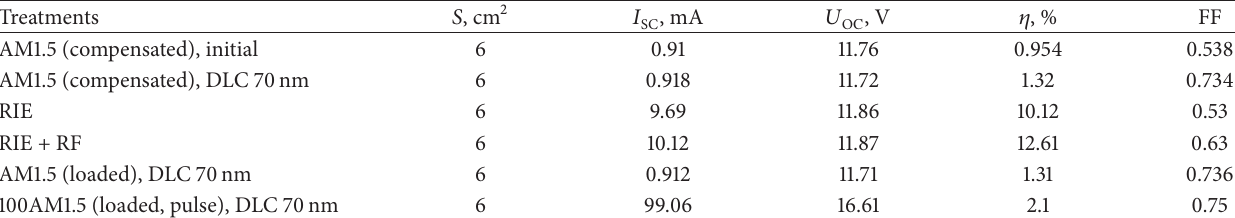
Table 2: Parameters of multijunction SCs cells under light